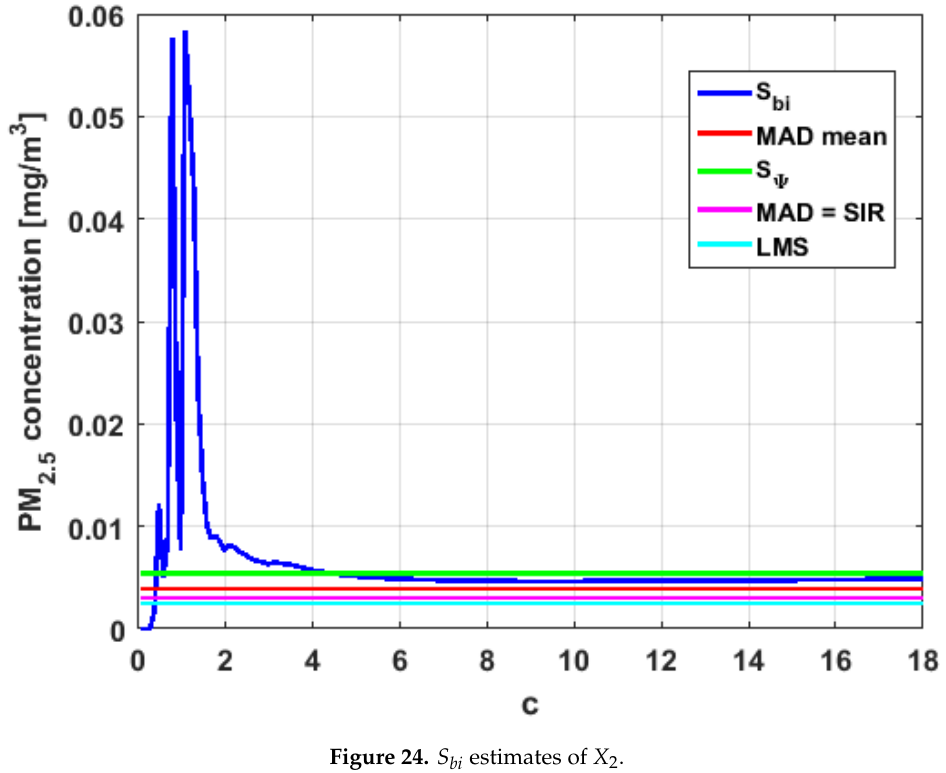
Figure 24. 𝑆 𝑏𝑖 estimates of 𝑋 2 . Figure 24. S bi estimates of X 2 .